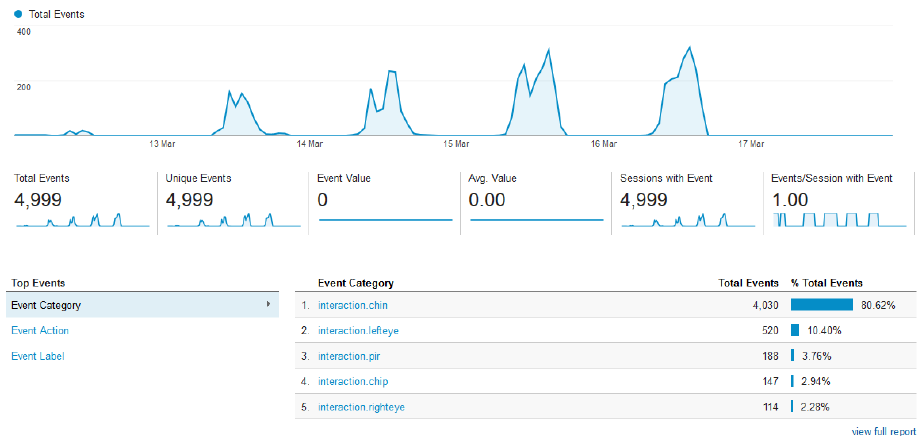
Figure 14. Daily counts of interactions with Erica at the Big Bang fair, recorded using Google